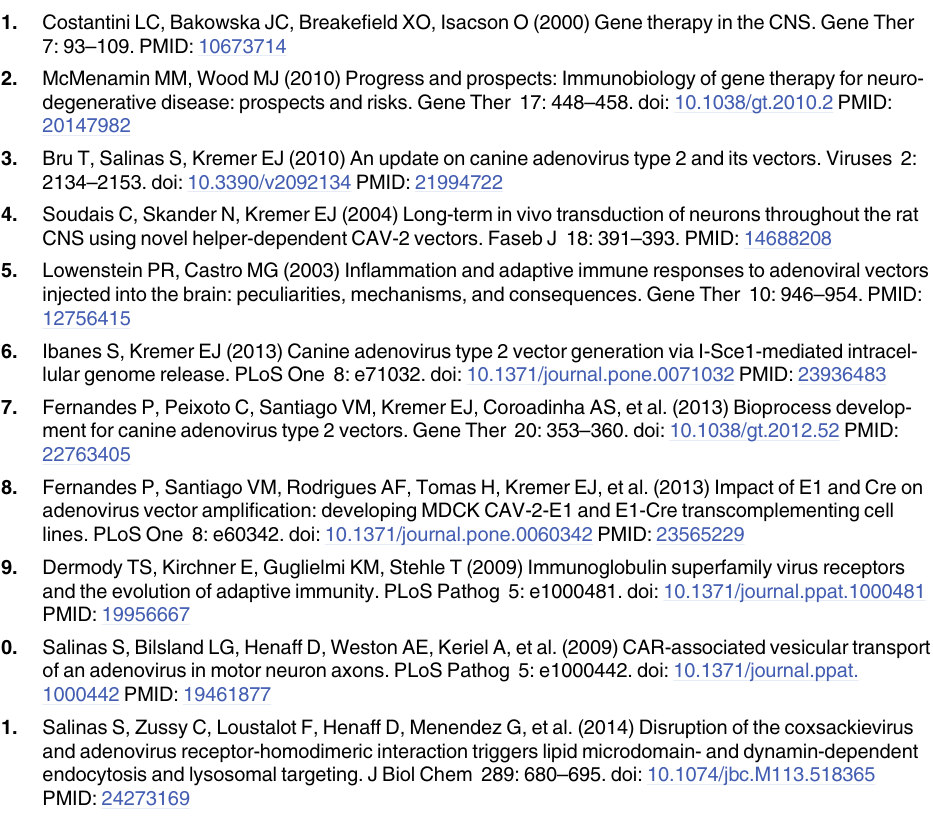
S2 Table. Functional classification of probes modulated uniquely in 3D hmNPCs by HD-CAV-2. g:Profiler gGOSt was used to classify the probes uniquely modulated in 3D culture conditions by HD-CAV-2. T indicates the number of genes associated to functional term, Q is the number of genes in input list. S3 Table. List of probes modulated uniquely in 2D hmNPCs by HD-CAV-2. In silico com- parison of transcriptome data obtained from 2D hmNPCs transduced at an MOI of 1000 with HD-CAV-2 with data obtained from HD-CAV-2